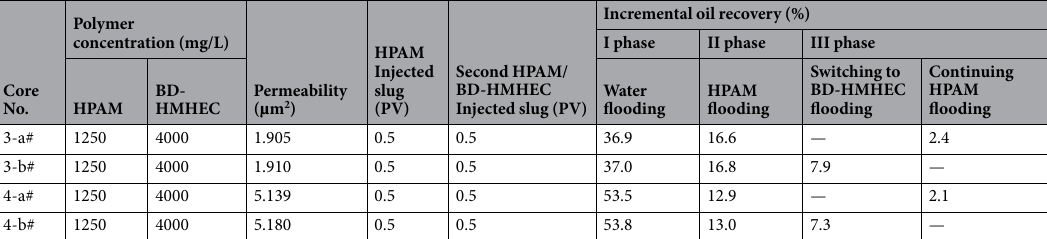
Table 3. The results of continuing HPAM and switching to BD-HMHEC flooding after water and HPAM flooding (injection rate: 0.5 mL/min).